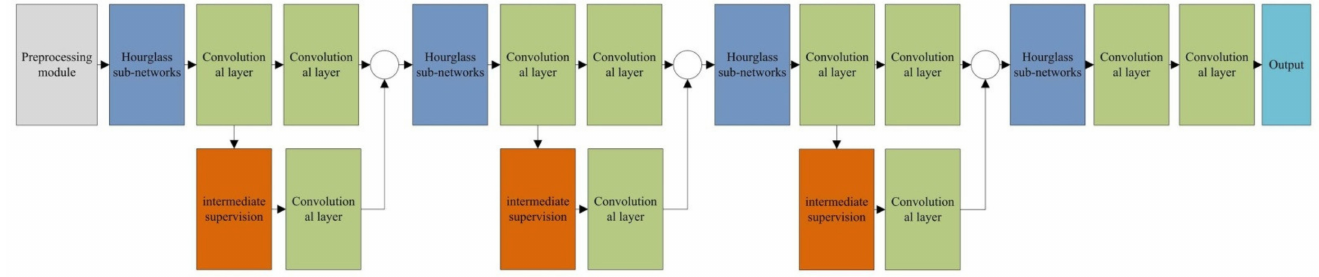
Figure 12. The structure of the three-level densely stacked hourglass